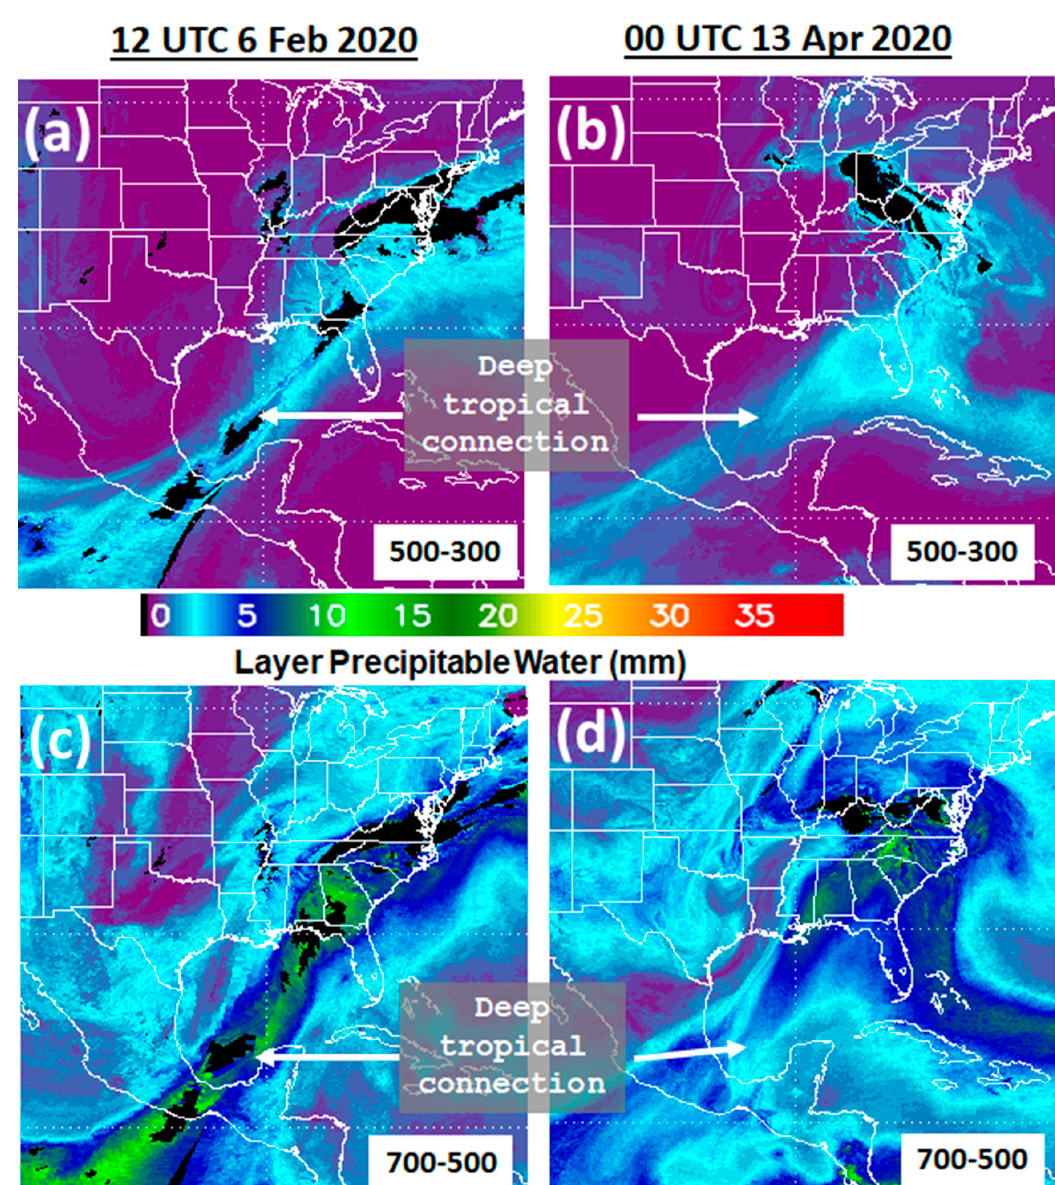
Figure 12. As in Figure 11, but for the ( a , b ) 500-300 and ( c , d ) 700-500 hPa